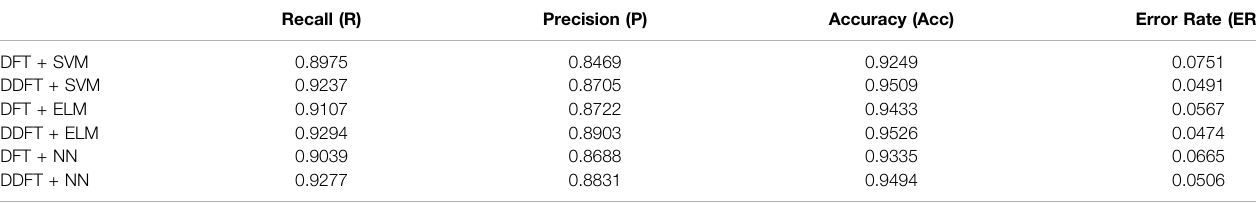
TABLE 2 | Performance of classi fi cation of power quality